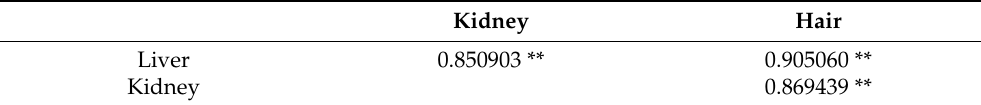
Table 2. Correlation coefficients between Hg concentrations in the tissues